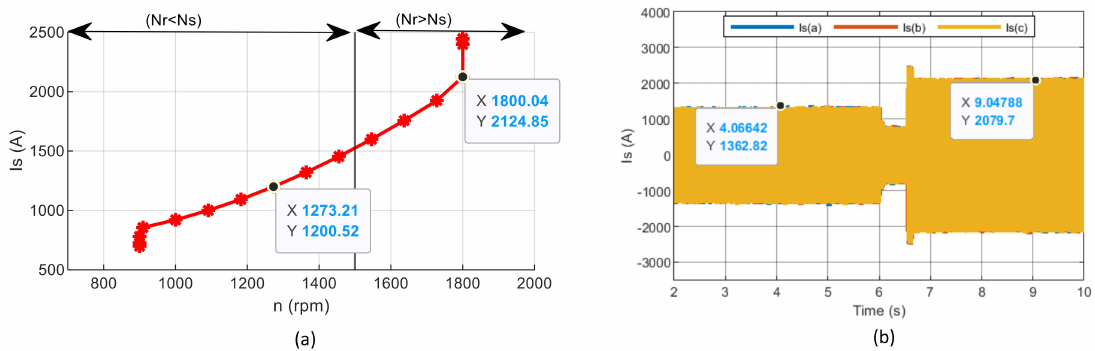
Figure 7. ( a ) Calculated stator current; ( b ) Stator current of the designed system. The values of rotor current are calculated to be 1011.98 A, which is similar to the simulated SS value of 1214.42 A for a speed of 1273.21 rpm. Again, for a speed of 1800 rpm, the calculated value of stator current is 2076.2 A and the SS value of 2114.37 A is within comparable limits. Figure 8a,b show the values for comparison.